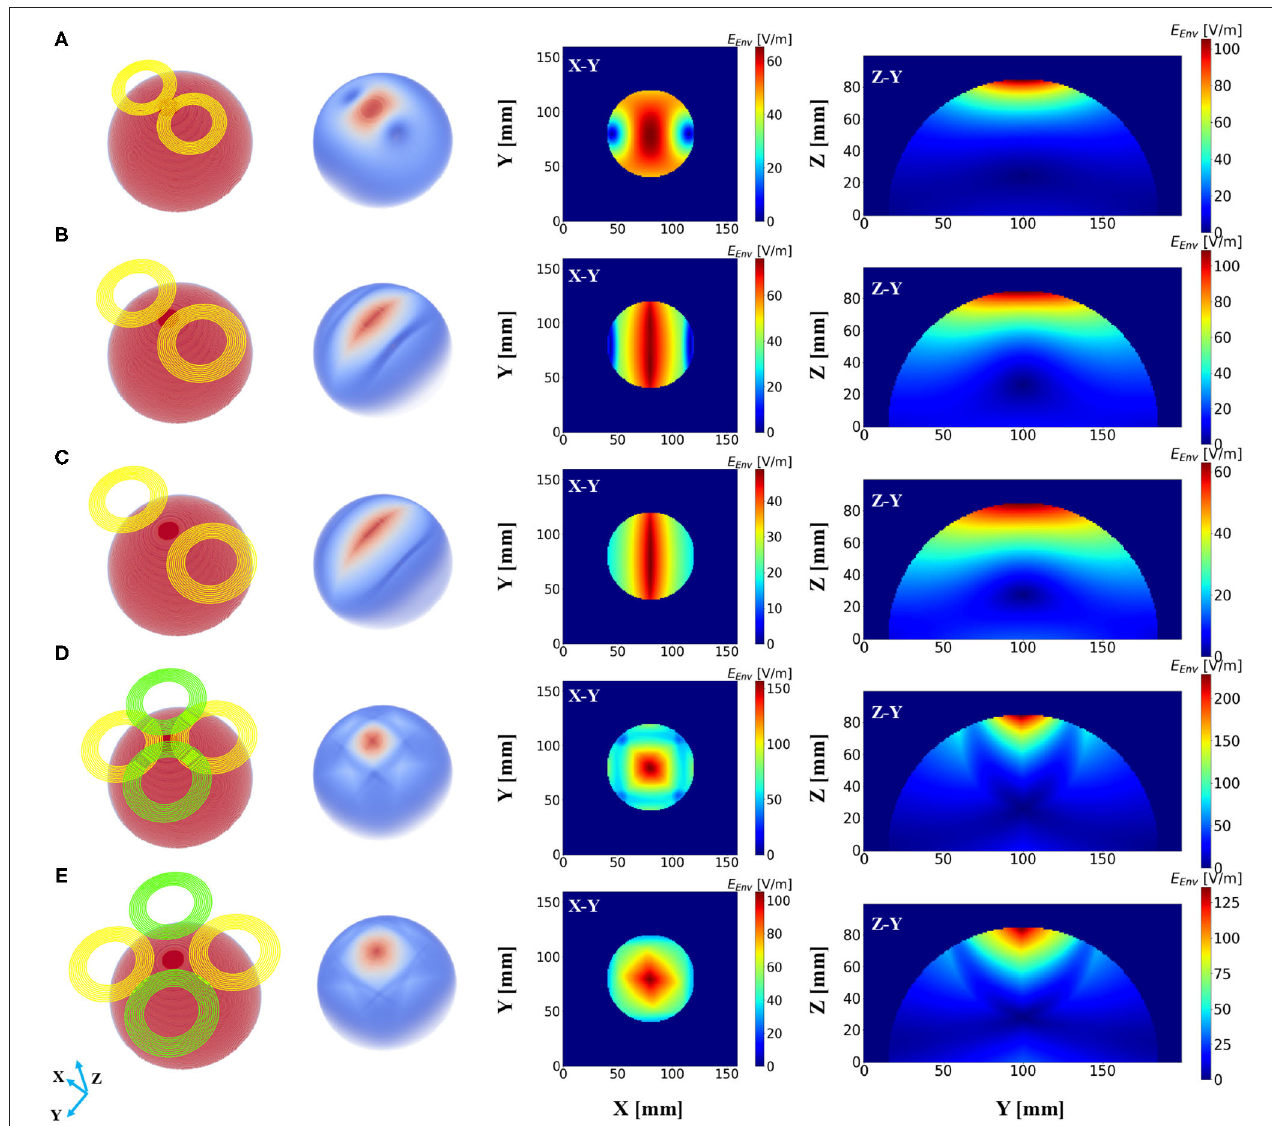
FIGURE 3 | Electric field distribution in the hemispherical model induced by distinct stimulation protocols. The first column shows the geometry of the stimulation coils, and the second column shows the overall dispersal of the inferential field. Cross-sections of the model from different direction axes are displayed in the last two columns. The current intensity in all the coils was determined to be 1 kA. (A) Magstim 70 mm figure-8 coil (P/N 9925, 3190). (B) Two-coil temporal interference magnetic stimulation with an edge distance of 10 mm. (C) Two-coil temporal interference magnetic stimulation with an edge distance of 40 mm. (D) Four-coil temporal interference magnetic stimulation with an edge distance of 10 mm. (E) Four-coil temporal interference magnetic stimulation with an edge distance of 40